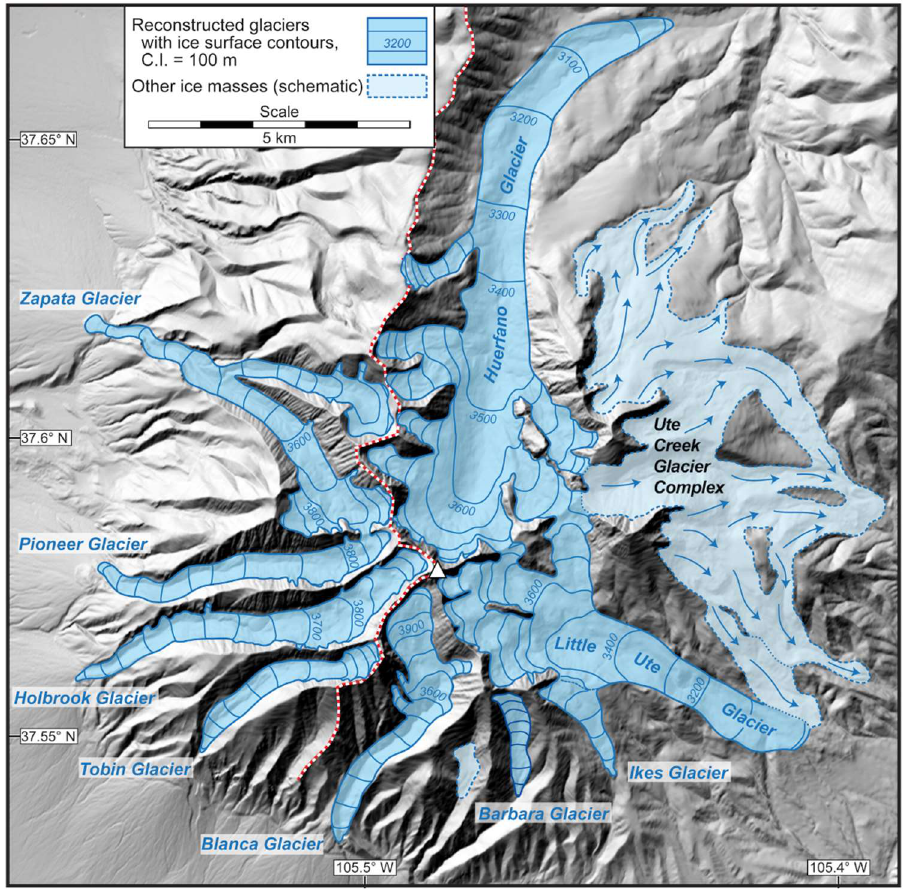
Figure 4. Reconstructed glaciers on the Blanca Massif at their maximum LGM extents. White triangle is Blanca Peak. The red and white dashed line delineates the range crest in the north and defines the eastern and western sides of the massif as defined in this study.